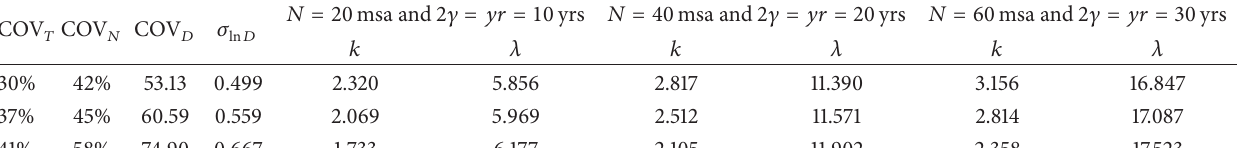
Table 1: Parameters of survival ( 𝑆(𝑡) ) function.